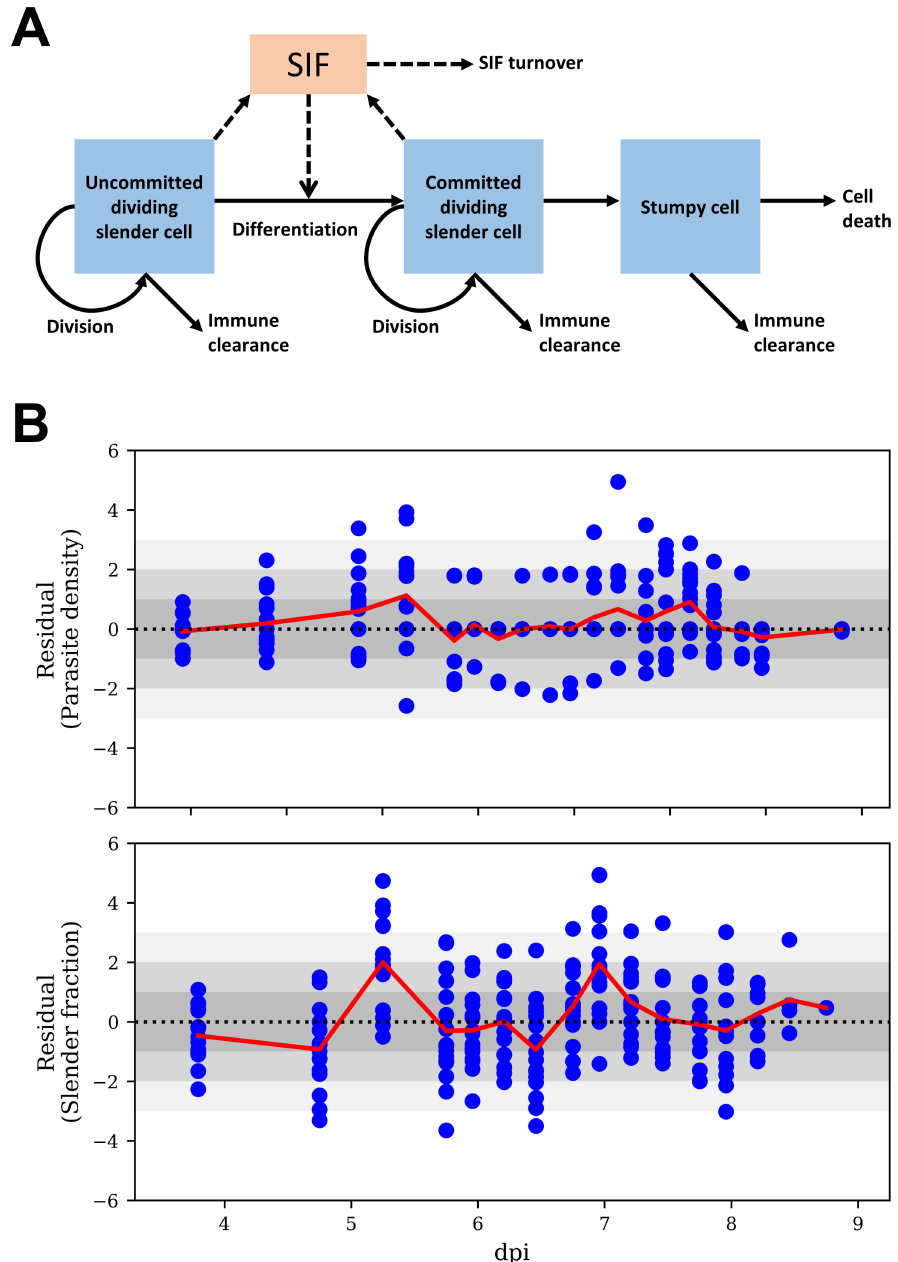
Fig 4. The mathematical model for T . brucei infection dynamics. (A) Schematic of the mathematical model. Slender cells can become committed to differentiation via a SIF dependent route, proportional to SIF concentration, and a SIF independent route. SIF is produced by both committed and non-committed slender forms, and is cleared over time. The concentration of each cell type depends on the replication rate (applicable to slender forms only), the immune clearance rate, the lifespan of that cell type and the differentiation rate (applicable to slender forms only). (B) Standardised residuals (blue circles) of parasite density and slender fraction, by time (dpi, days post infection), of the model fits with SIF-dependent and -independent differentiation to all mice. Under a true model standardised residuals have an approximately standard normal distribution (i.e., zero mean and unit standard deviation (SD)). Inadequate fit of a model is indicated by its residuals deviating from a standard normal distribution (such as residuals further than ~3 SD from zero, represented by the lightest grey shading, or a set of residuals consistently above or below zero. The red line shows the average, across all mice, of the residuals at a particular time